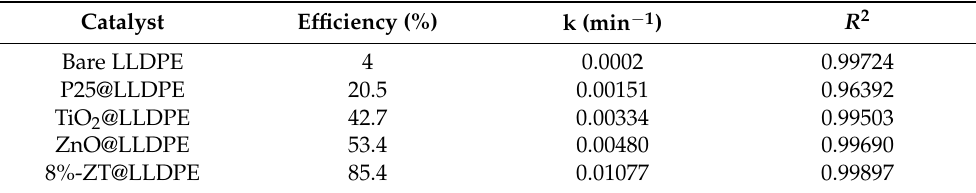
Table 1. Kinetic data for the photodegradation of TC using LLDPE hybrid